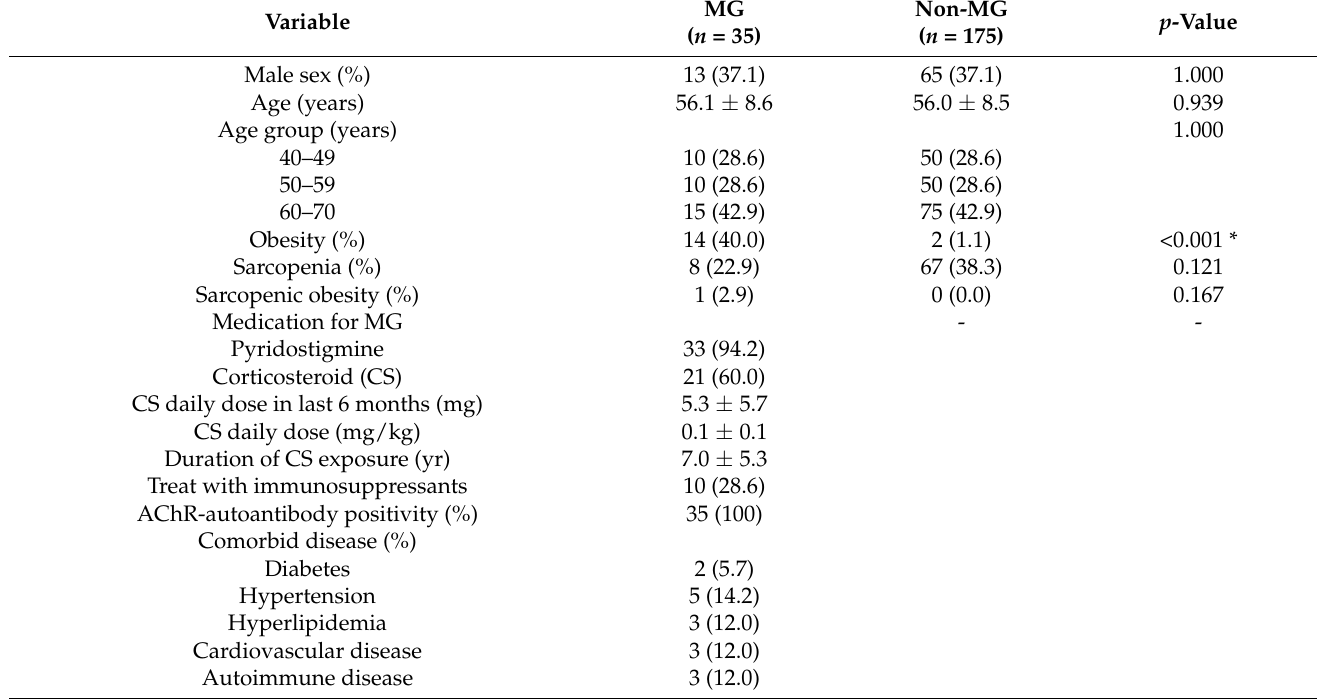
Table 1. Clinical characteristics of patients with MG and sex- and age-matched